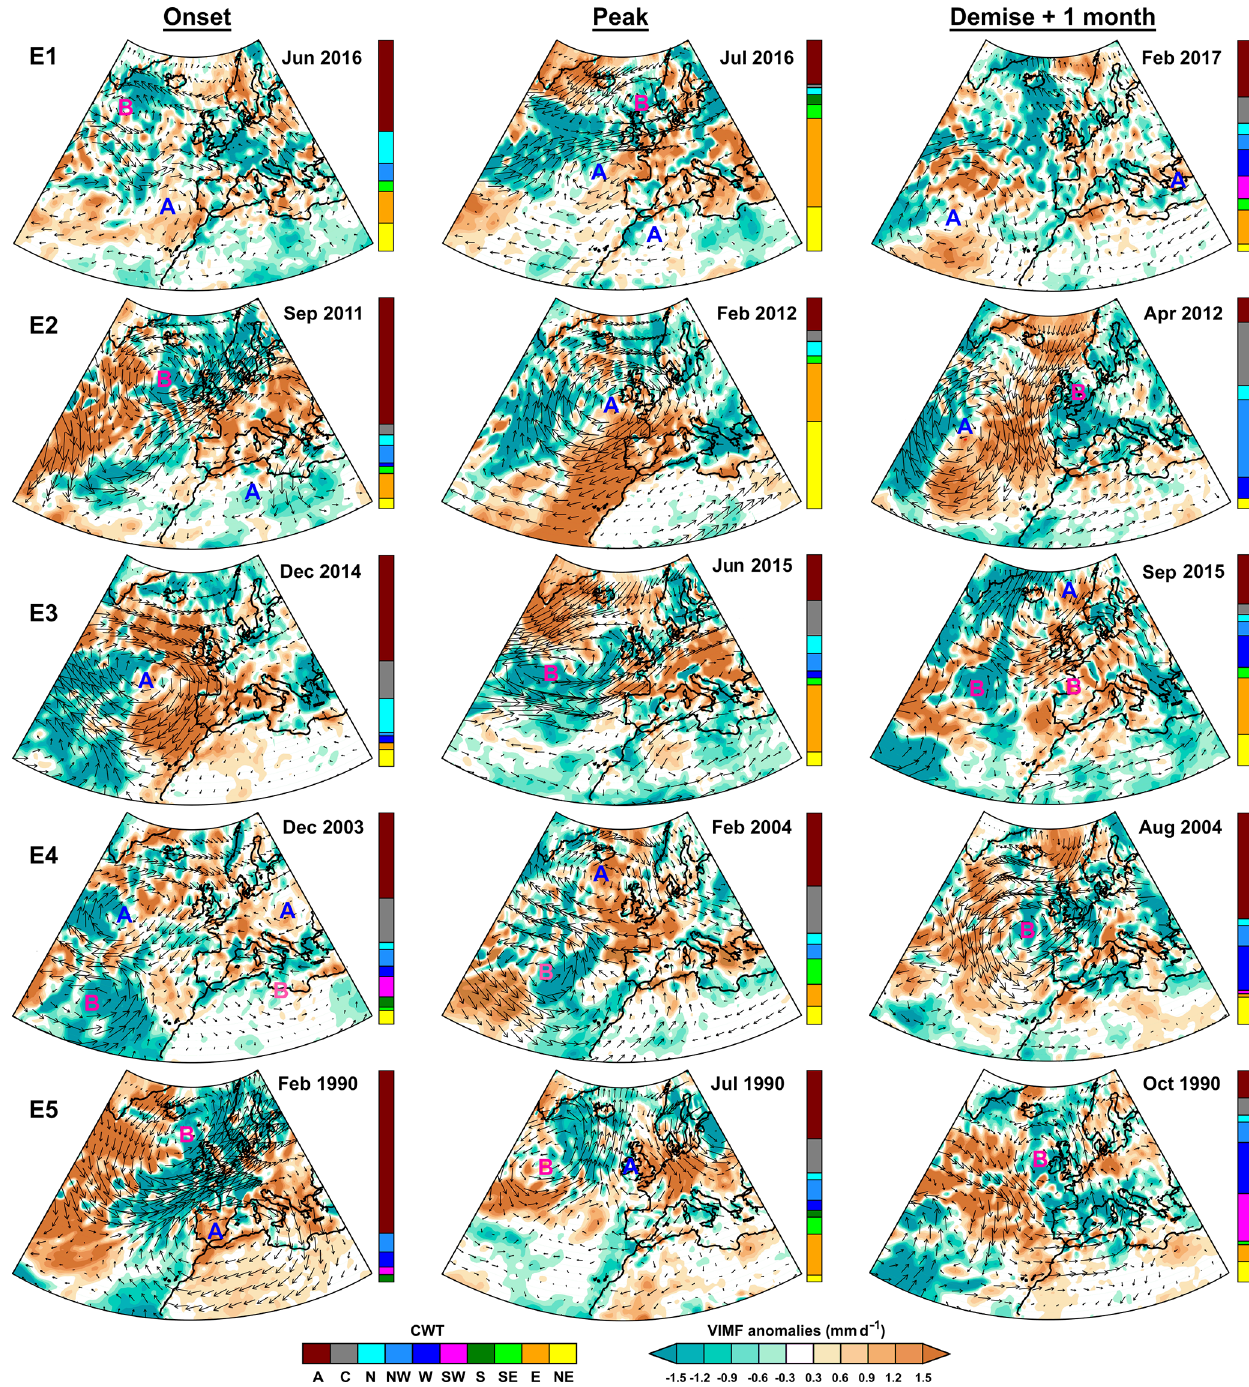
the contrary, another study showed that the AO ranged from positive to negative values depending on pressure anoma- lies in the Arctic region (Thompson and Wallace, 1998). A band of strong winds circulating around the North Pole as- sociated with the positive phase of the AO kept colder air